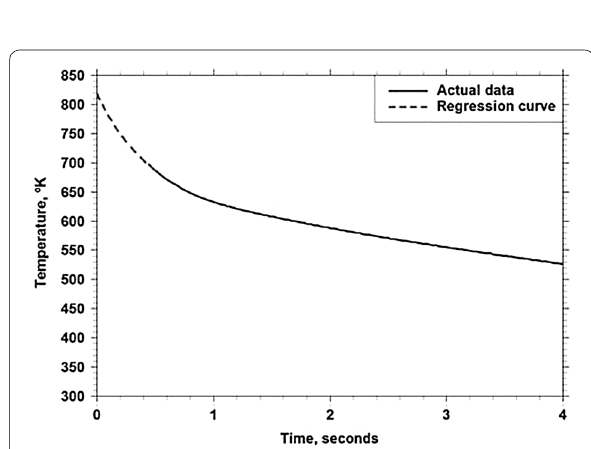
Figure 13 Relationship between the temperature and the welding time [81]